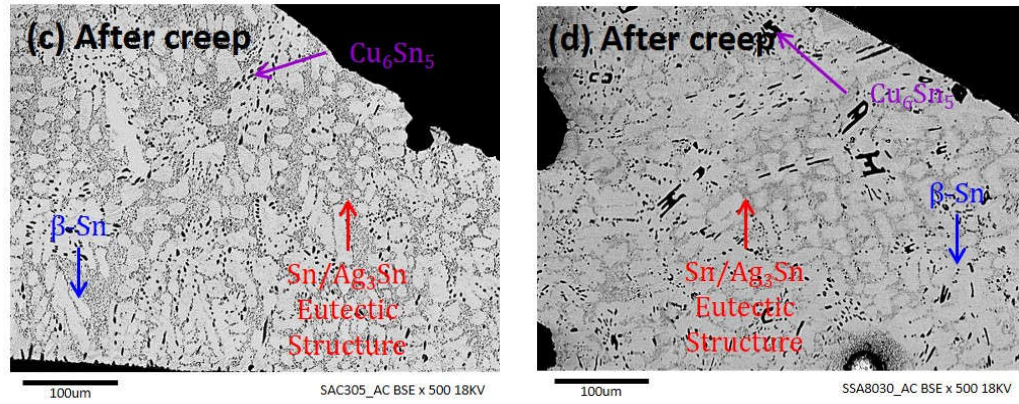
Figure 6. Microstructure before and after the creep test, respectively, for ( a , c ) SAC305 and ( b , d ) SSA8030 solders.